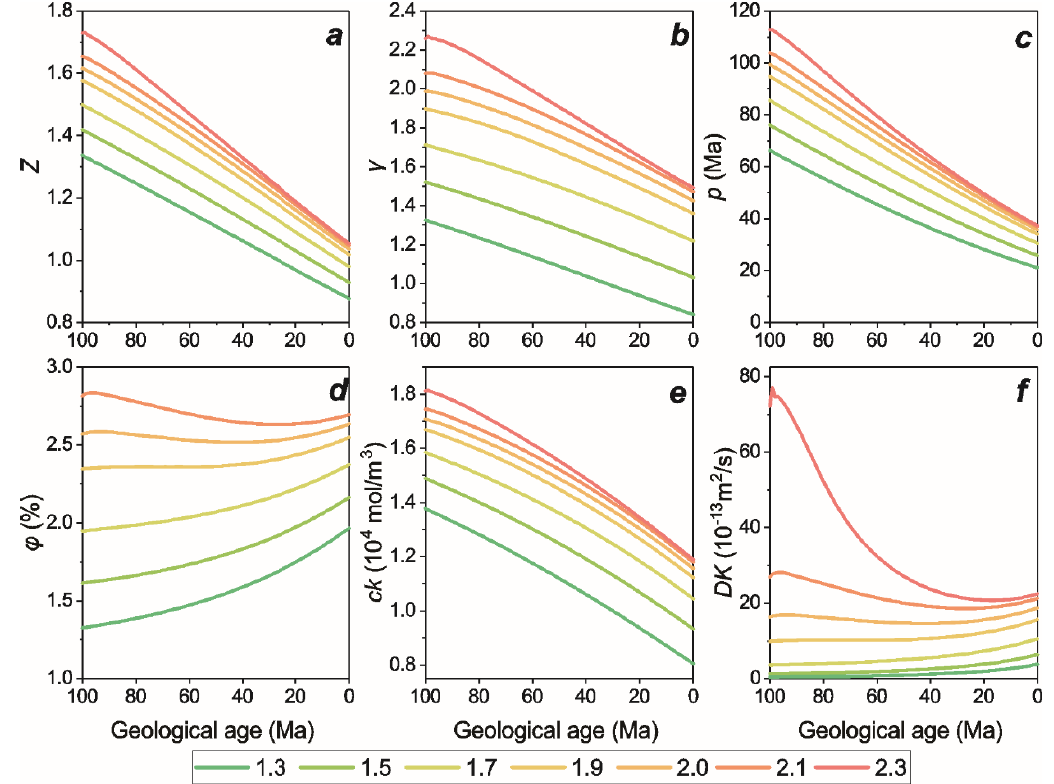
Figure 12. Evolution of compression coefficient ( a ), pressure coefficient ( b ), reservoir pressure ( c ), porosity ( d ), free gas concentration ( e ) and diffusion coefficient ( f ) for the different initial pressure coefficients ( γ 0 ) of the CN well after uplift.